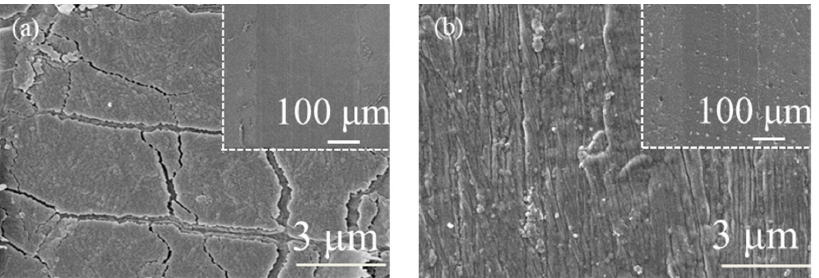
Figure 14. The wear rate of UHMWPE substrates treated with different carbon plasma currents under two environments.